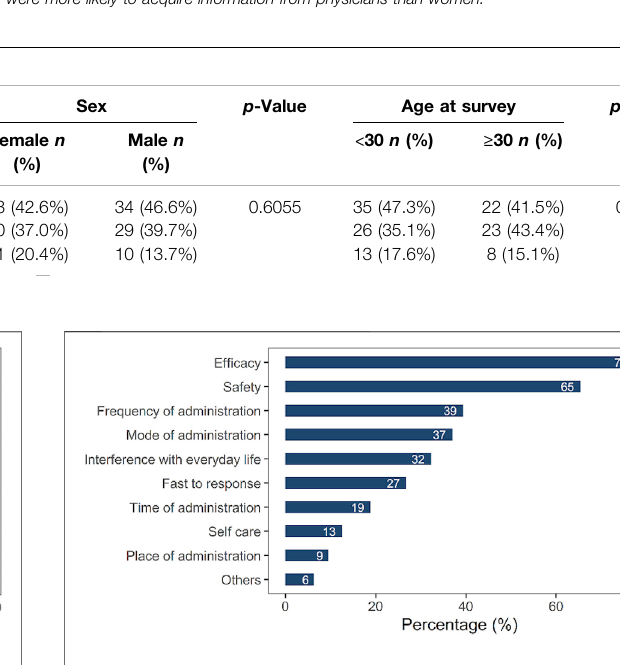
FIGURE 2 | Candidate drugs before ustekinumab (UST) therapy. FIGURE 3 | Reasons for the choice of